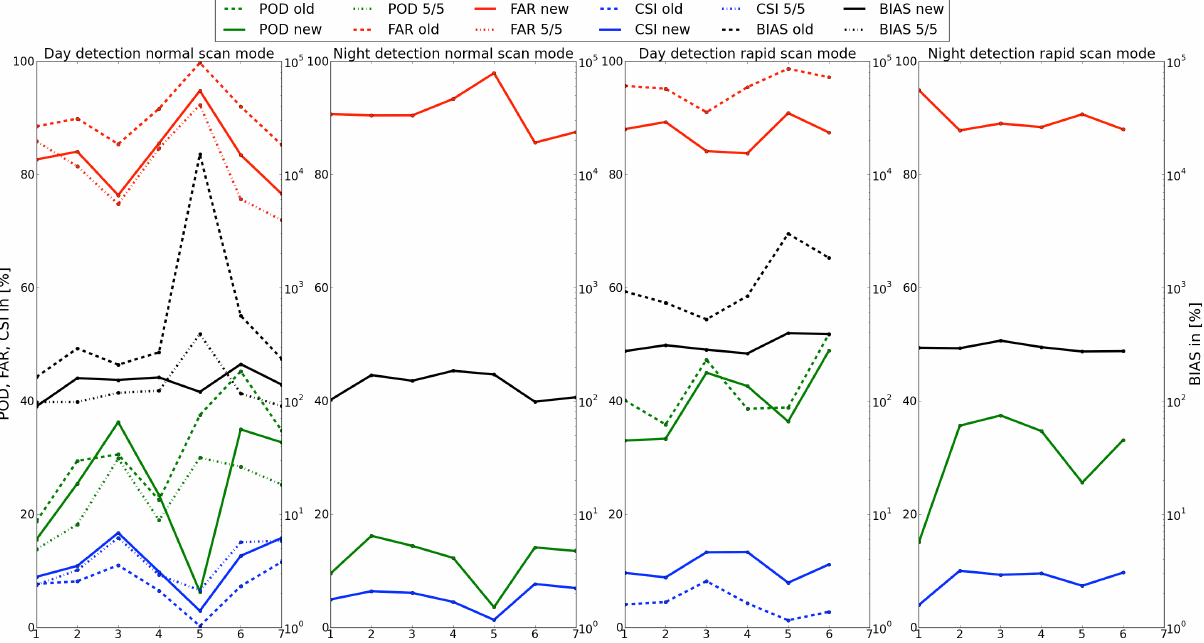
Fig. 5. POD, FAR, CSI and BIAS for the test days: green, red, blue and black lines, respectively. Dashed lines mark the original CI detection algorithm results, while the bold lines mark the new CI detection results; dotted lines in the left figure mark the new nighttime detection mode applied to the daytime data (using the five IR criteria